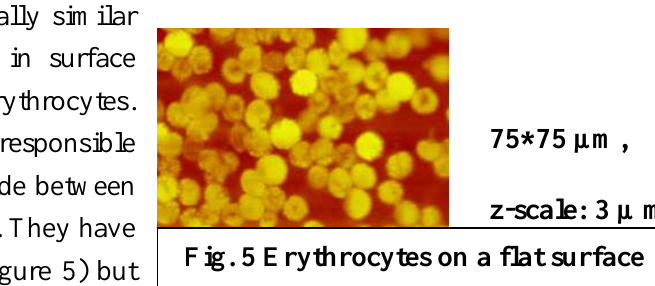
Fig. 5 Erythrocytes on a flat